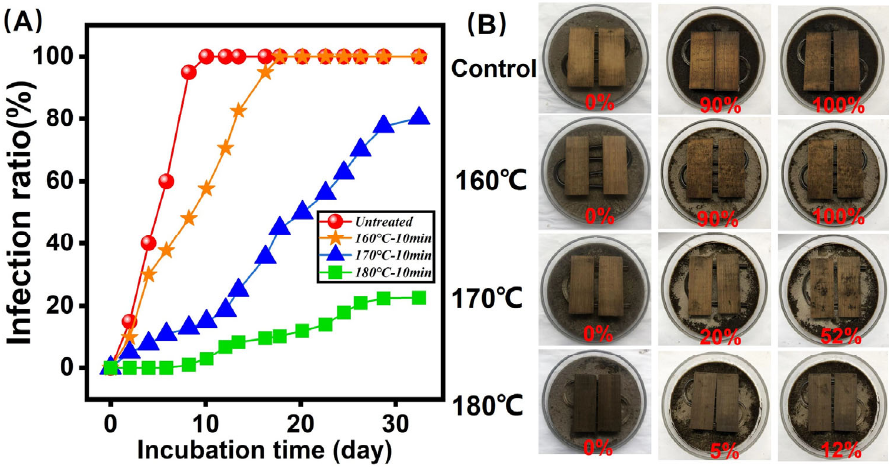
Figure 7. Micro ‐ mechanical property characterization. ( A ) Infection ratio in one month; ( B ) Picture of anti ‐ mold test in one